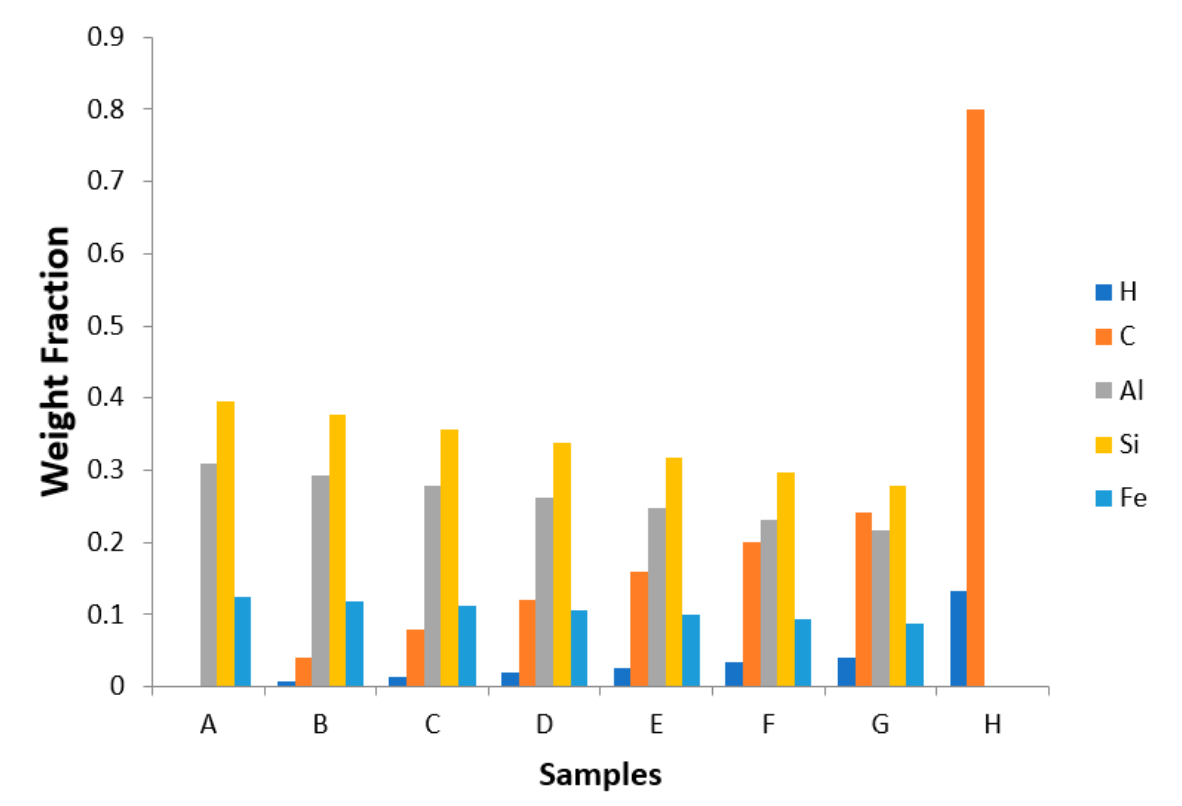
Figure 8. Variation of H, C, Al, Si and Fe weight fraction in the